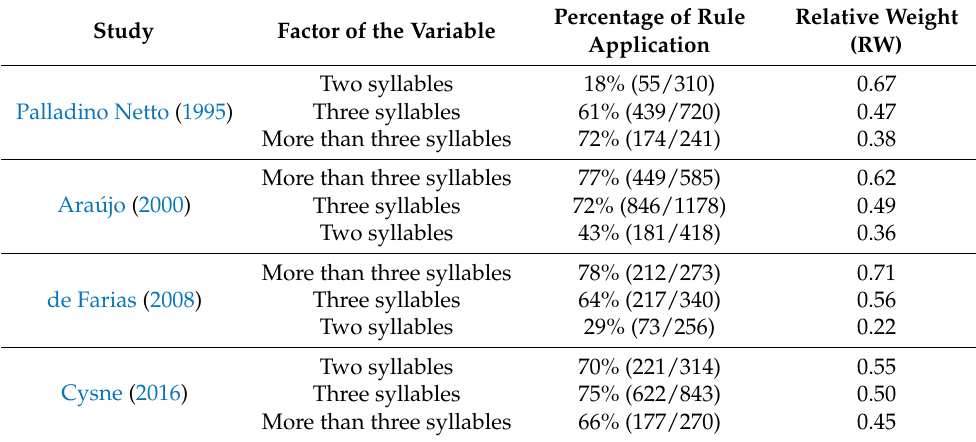
Table 8. Effects of the factors of the variable number of